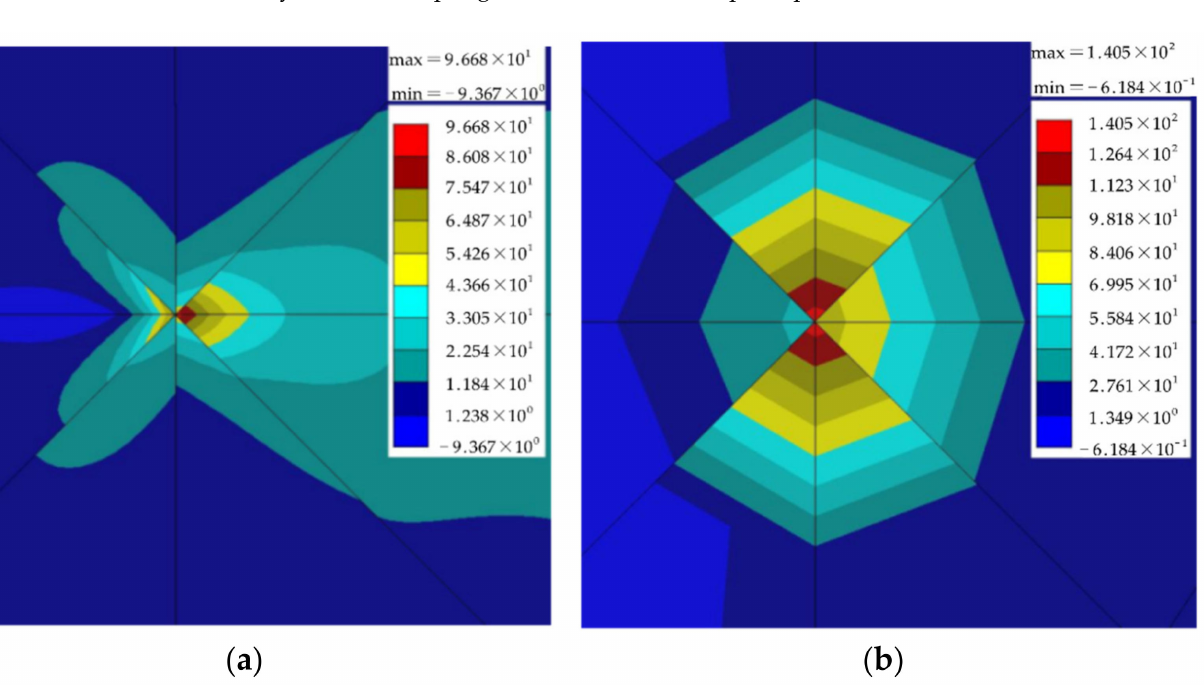
Figure 3. The stress nephogram at the left crack tip: ( a ) x -axis direction; ( b ) y -axis